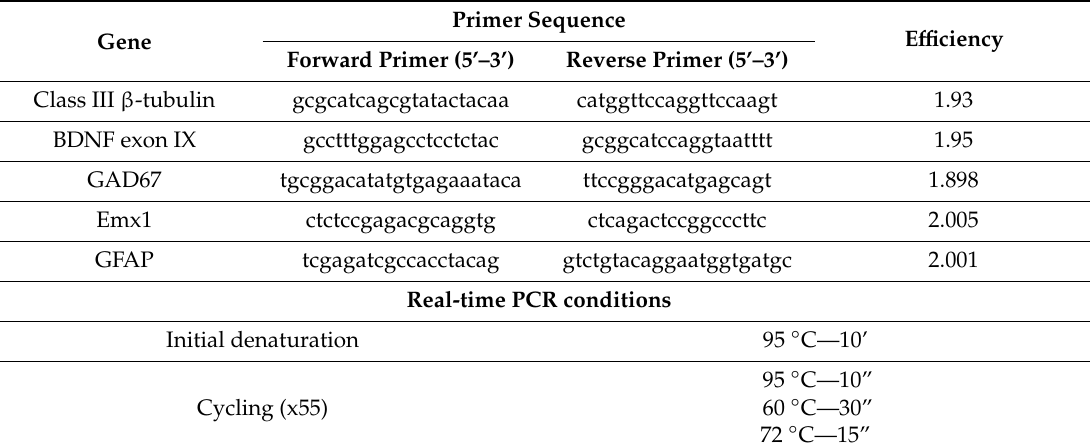
Table 6. List of primers used for qPCR and amplification